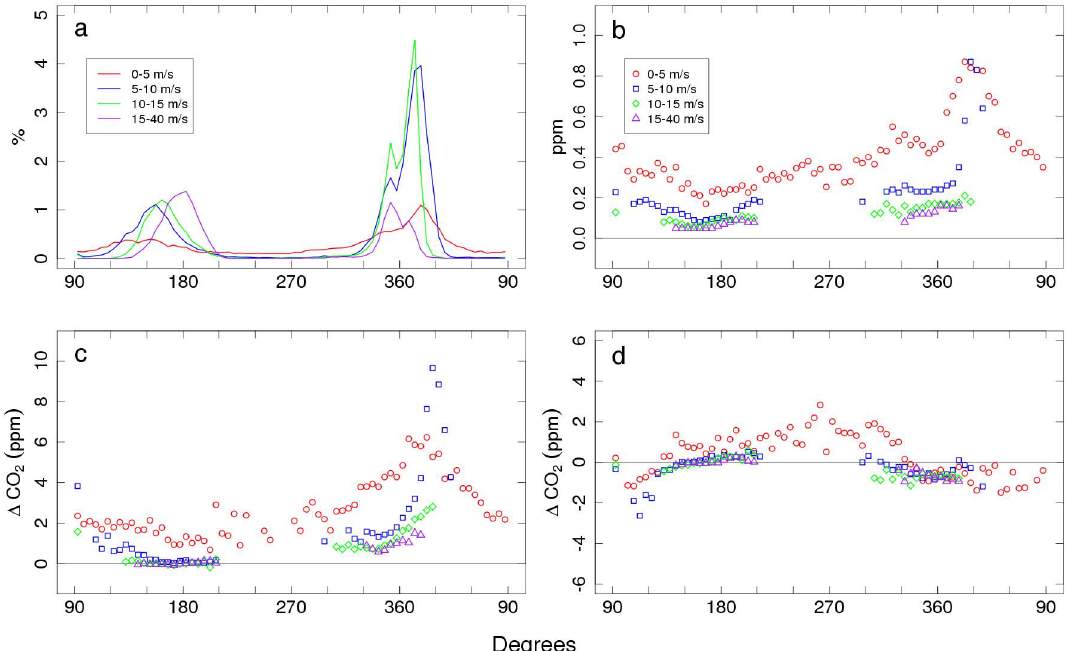
Fig. 2. Influence of wind speed and direction on CO 2 mole fractions and variability as derived from Baring Head data from 1997–2011. (a) Wind direction distributions for four different wind speed ranges shown as percentage of all winds in 5-degree increments. (b) Hourly CO 2 variability (1-sigma) as a function of wind direction for four different wind speed ranges. (c) Differences between nighttime (22:00– 04:00LST) hourly mean observed CO 2 mole fractions and interpolated steady period data for four different wind speed ranges. (d) Same as (c) but for daytime (10:00–16:00LST). For (b–d) , points are only plotted if that wind direction and speed bin represents 0.05% or greater of all wind